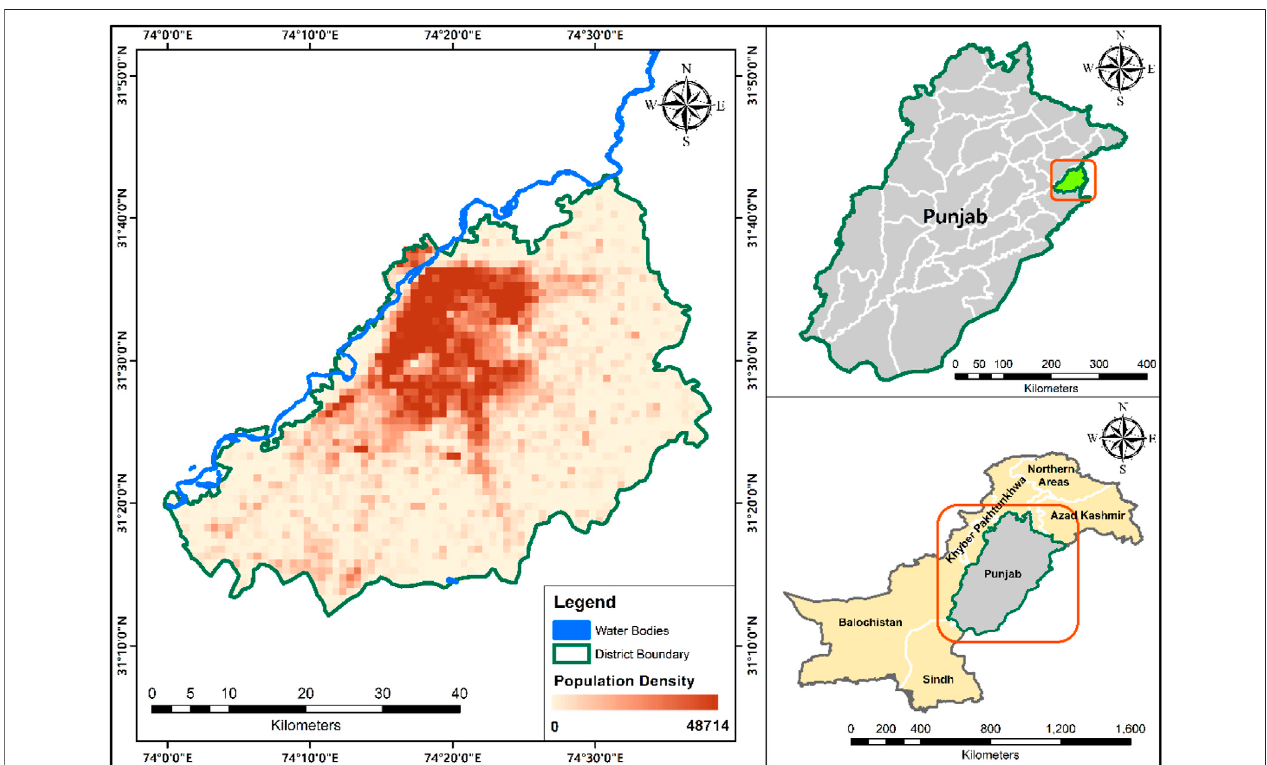
FIGURE 1 | Location map of the study